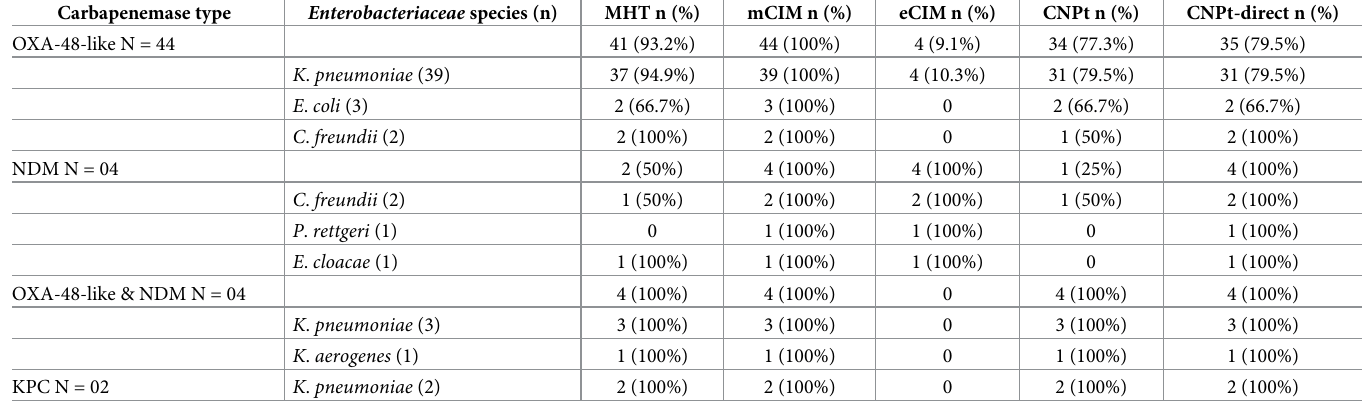
Table 2. Performance of four carbapenemase detection tests according to the type of carbapenemase and organism. Carbapenemase